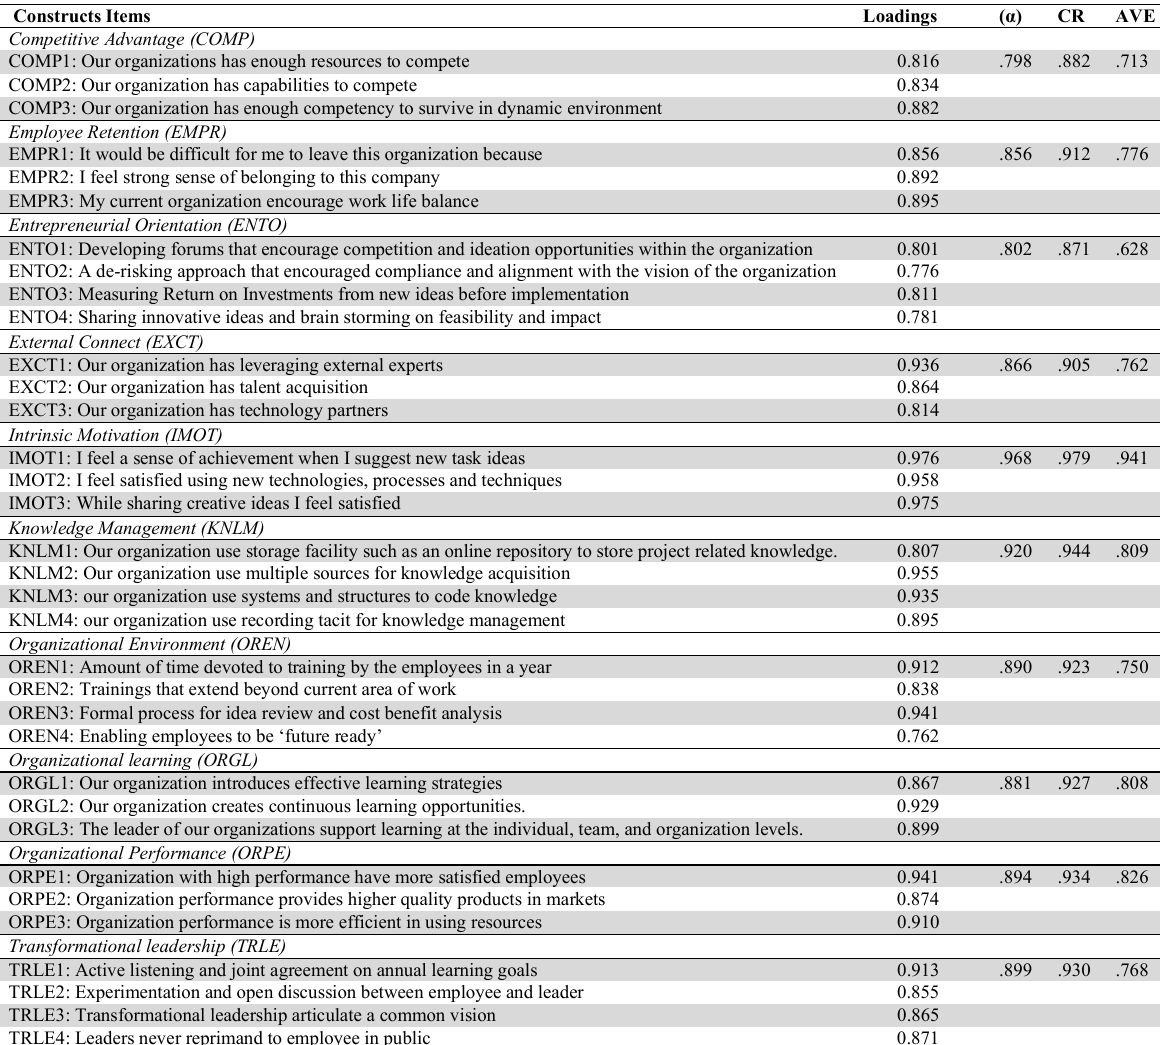
Measurement model Constructs